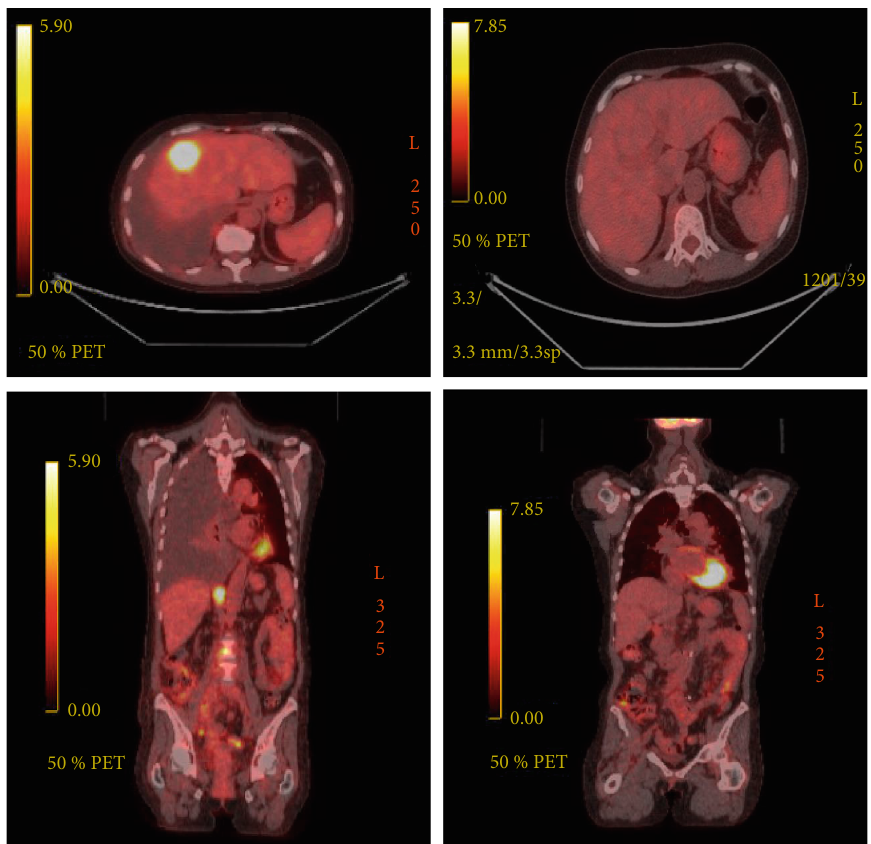
Figure 2: PET/CT scans showing improvement in metastatic disease with reduction in hepatic mass and decreased retroperitoneal, pelvic, and iliac lymphadenopathy after 4 cycles of